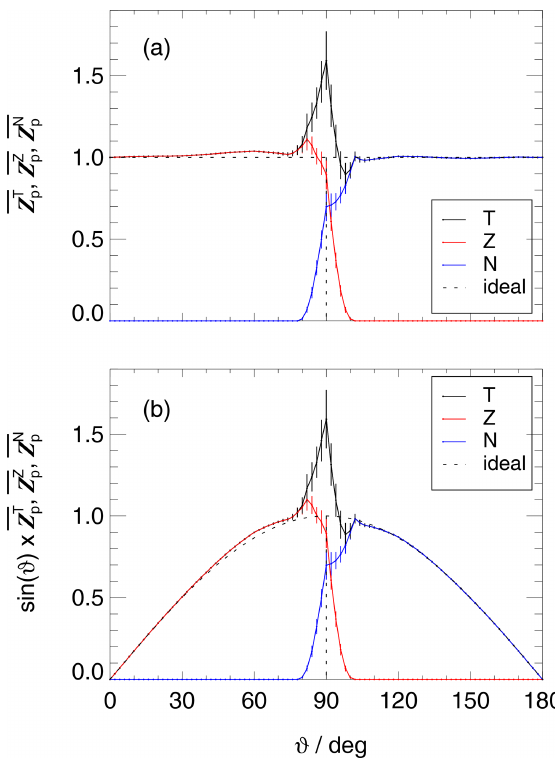
Figure 7. (a) Azimuthal averages of total relative angular sensitivi- ties Z T p (T) of HALO shown in Fig. 6 with contributions Z Z p (Z) and Z N p (N) of top and bottom receivers, respectively, for a wavelength of 400nm (2 ◦ interpolations). Error bars represent estimated mean uncertainties not covering azimuthal variabilities. The sensitivities of ideal 2 π and 4 π receivers are shown for comparison (dashed lines). (b) The same data as in panel (a) but multiplied by sin (ϑ) to account for the ϑ dependence of solid-angle